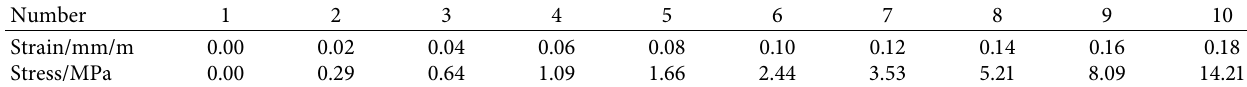
Table 3: Cap pressure of the double-yield model.